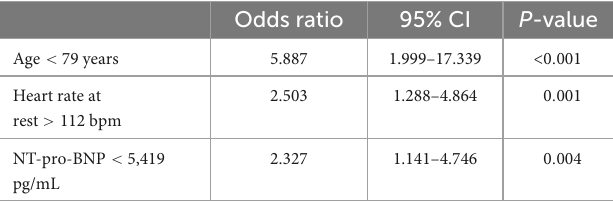
TABLE 3 Multivariate regression analysis for the indicators of AF/AFL induced TCM. Odds ratio 95% CI P -value Age < 79 years 5.887